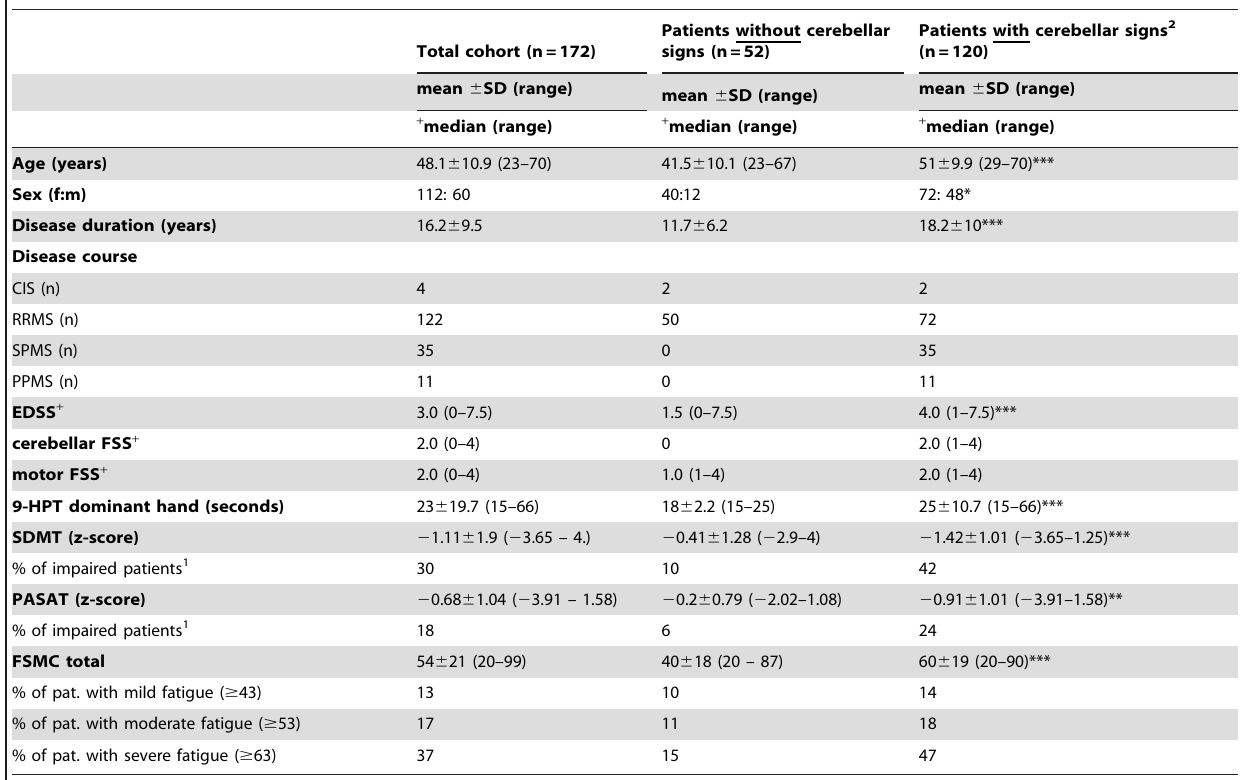
Table 1. Demographic and clinical data.